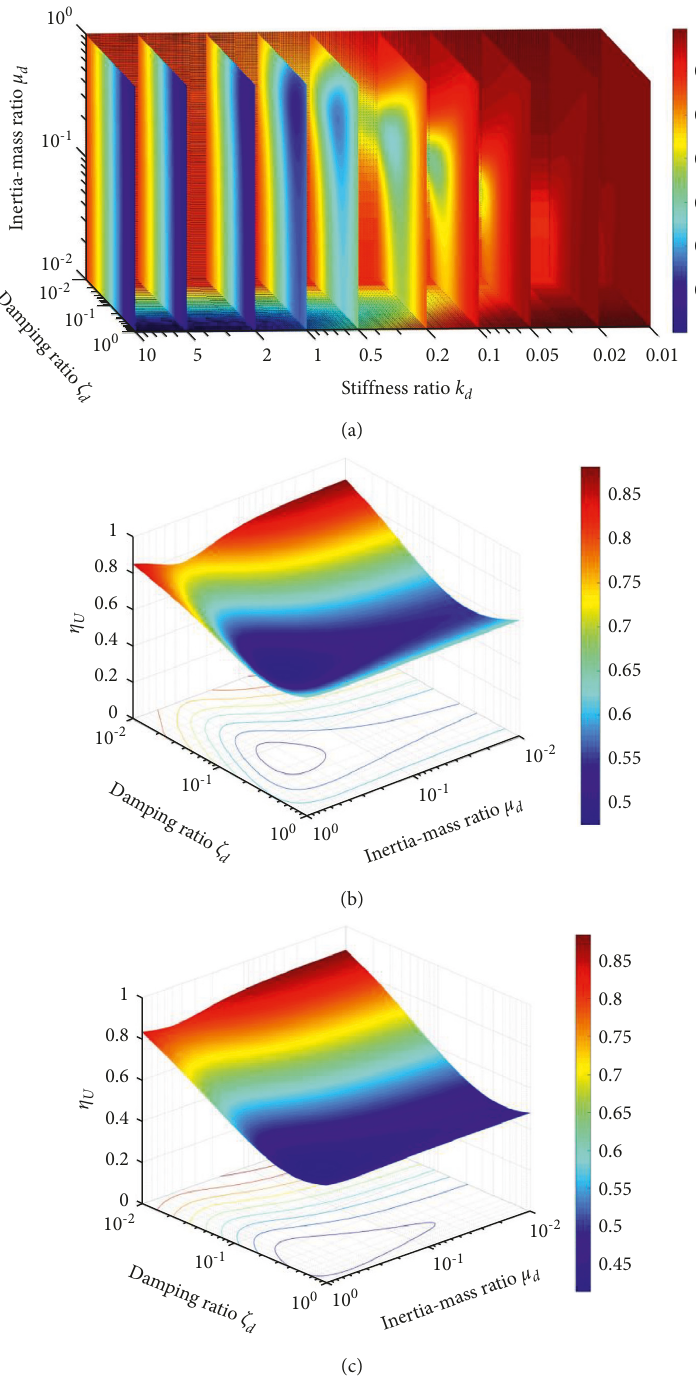
Figure 6: Mitigation ratio of displacement response: (a) changing κ